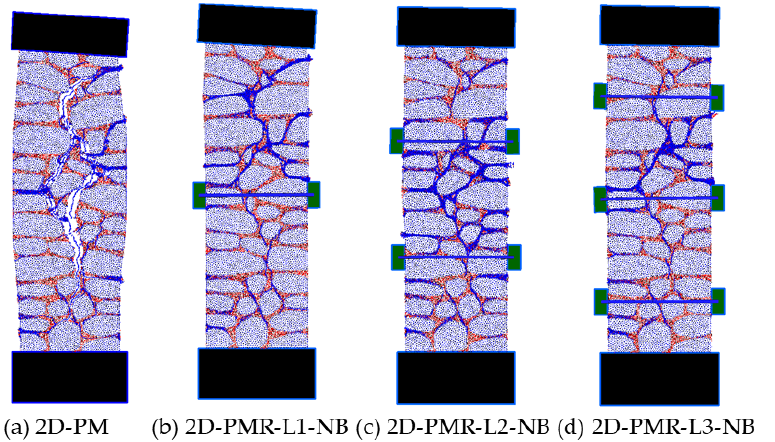
Figure 17. Numerical models: contact damage distribution for URM and RM models without a